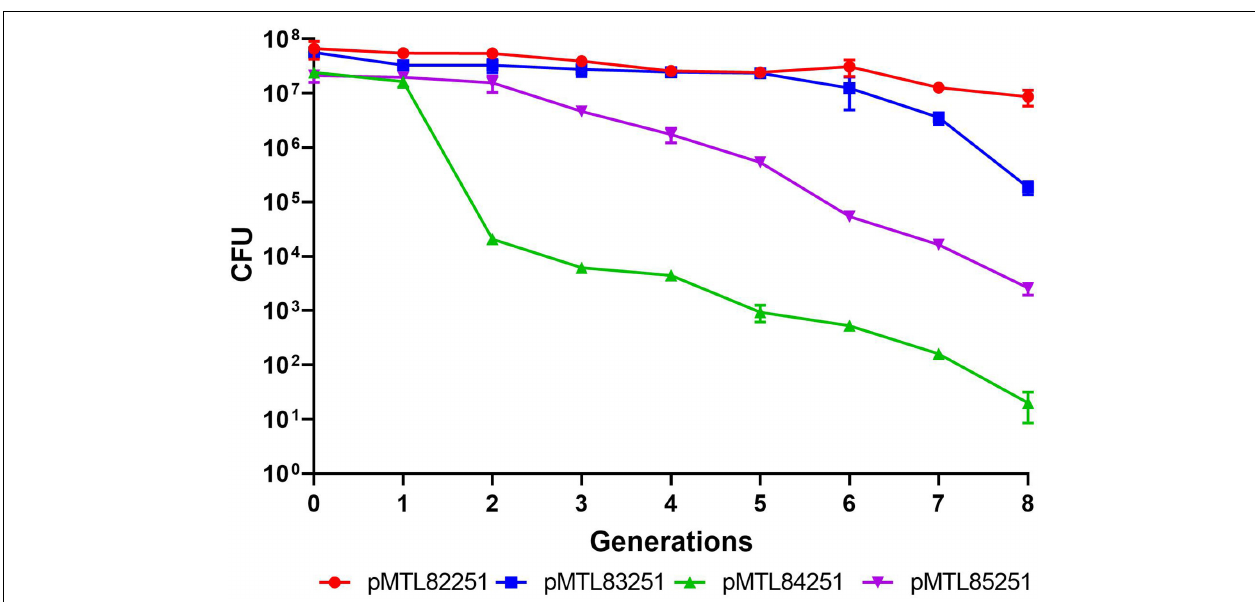
FIGURE 2 | Plasmid stability assay testing four Gram-positive replicons in C. saccharoperbutylacetonicum . Plasmid pMTL82251 with pBP1 replicon in red circles, pMTL83251 with pCB102 replicon in blue squares, pMTL84251 with pCD6 replicon in green upward pointing triangles and pMTL85251 with pIM13 replicon in downward pointing